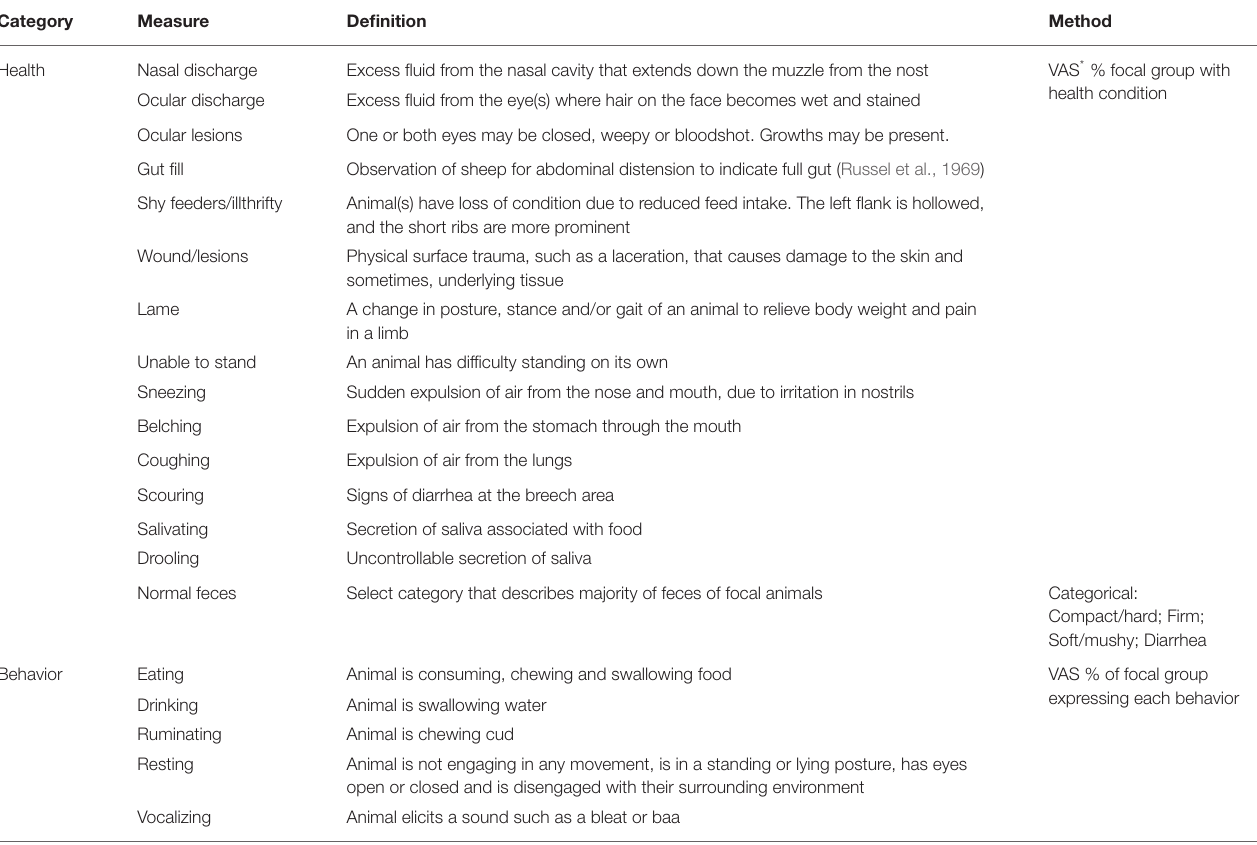
TABLE 1 | Ethogram of health (Jubb and Perkins, 2015) and behavior and the method of collection.